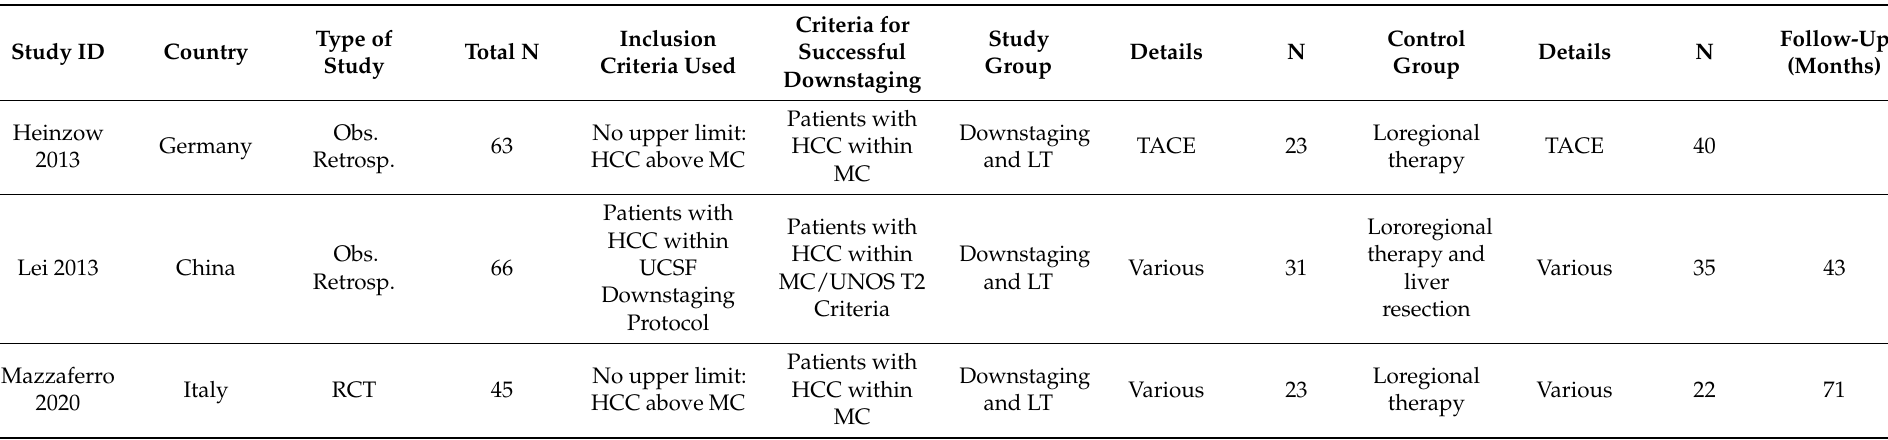
Table 3. Characteristics of included studies on Question 2: patients initially beyond listing criteria downstaged and submitted to liver transplantation vs. those downstaged and not